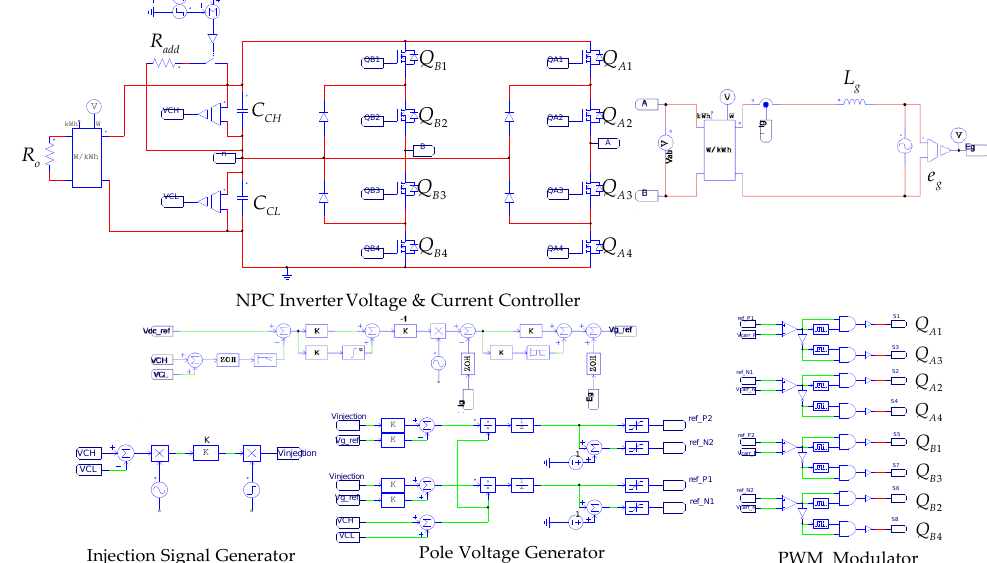
Figure 7. PSIM scheme for capacitor voltage balancing control.